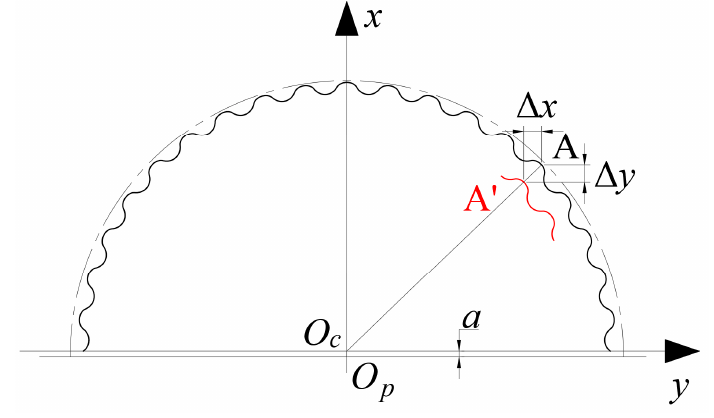
Figure 6. Schematic diagram of the tooth profile variation. The coordinate equation of the cycloidal gear profile after compensation is obtained by combining Formulas (1)~(3) and related formulas in Table 1.